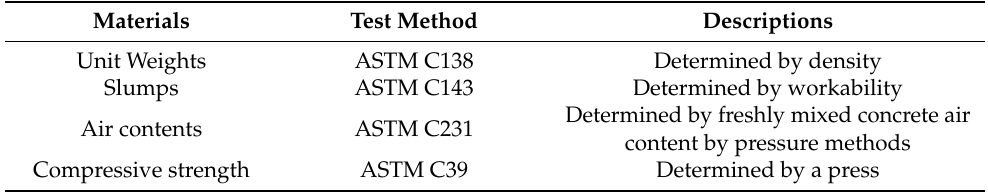
Table 3. Tests carried out on cement composites as per the ASTM